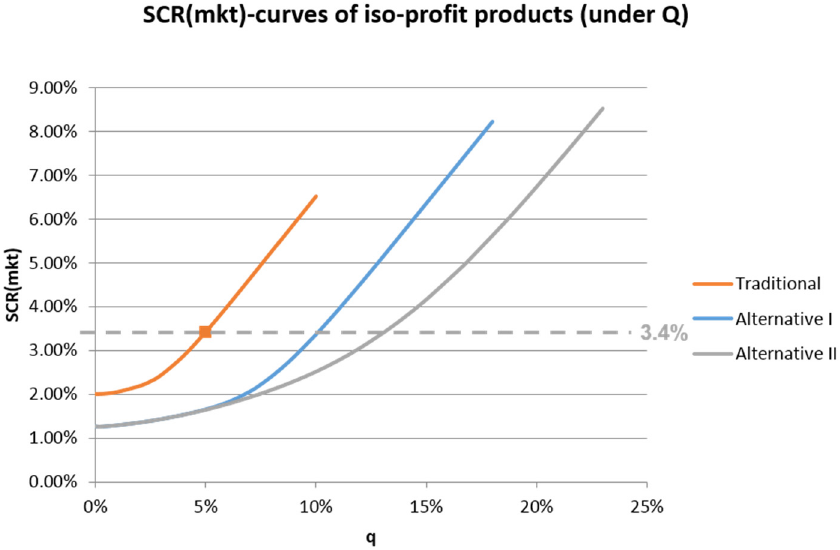
Figure 2. SCR mkt curves of the iso ‐ profit products.